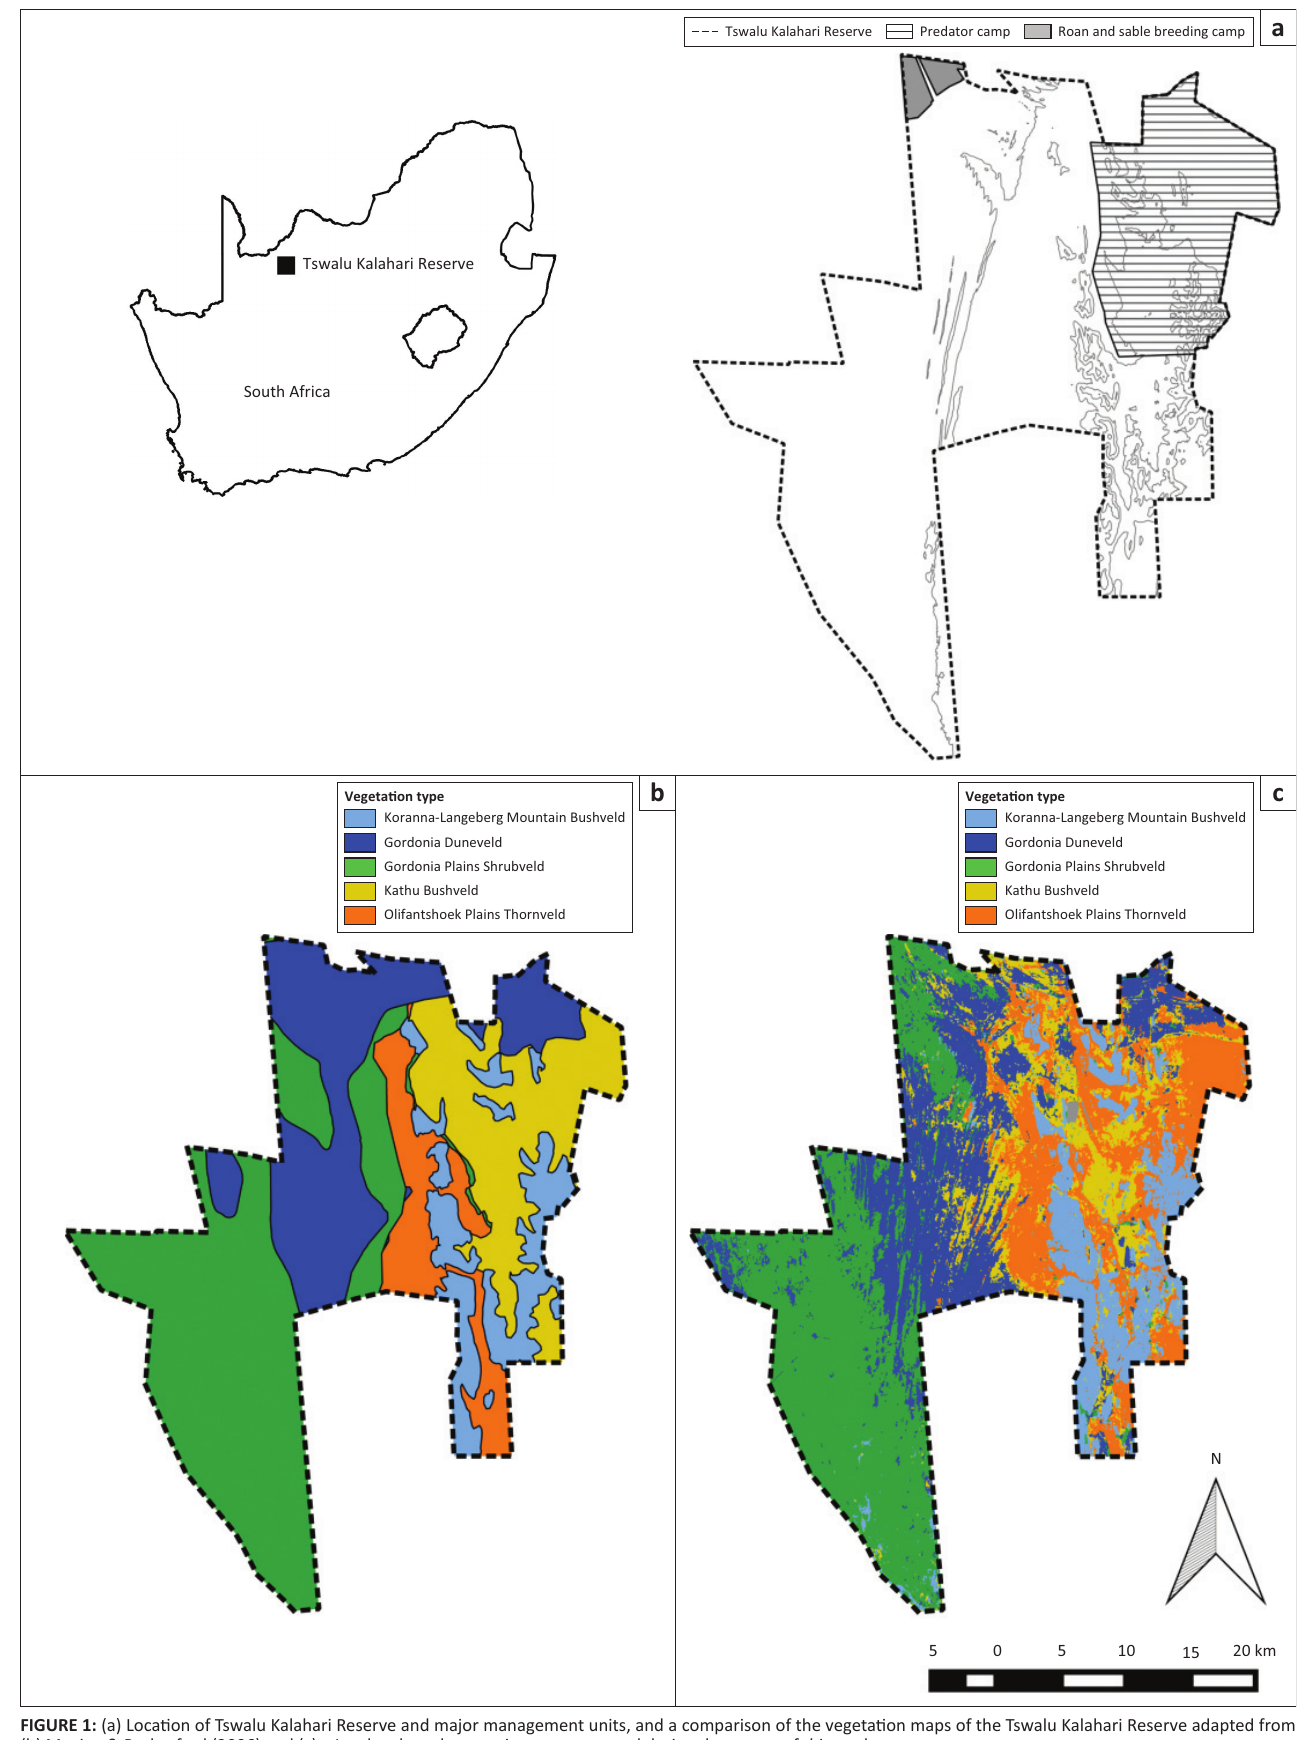
FIGURE 1: (a) Location of Tswalu Kalahari Reserve and major management units, and a comparison of the vegetation maps of the Tswalu Kalahari Reserve adapted from (b) Mucina & Rutherford (2006) and (c) a Landsat-based vegetation map prepared during the course of this